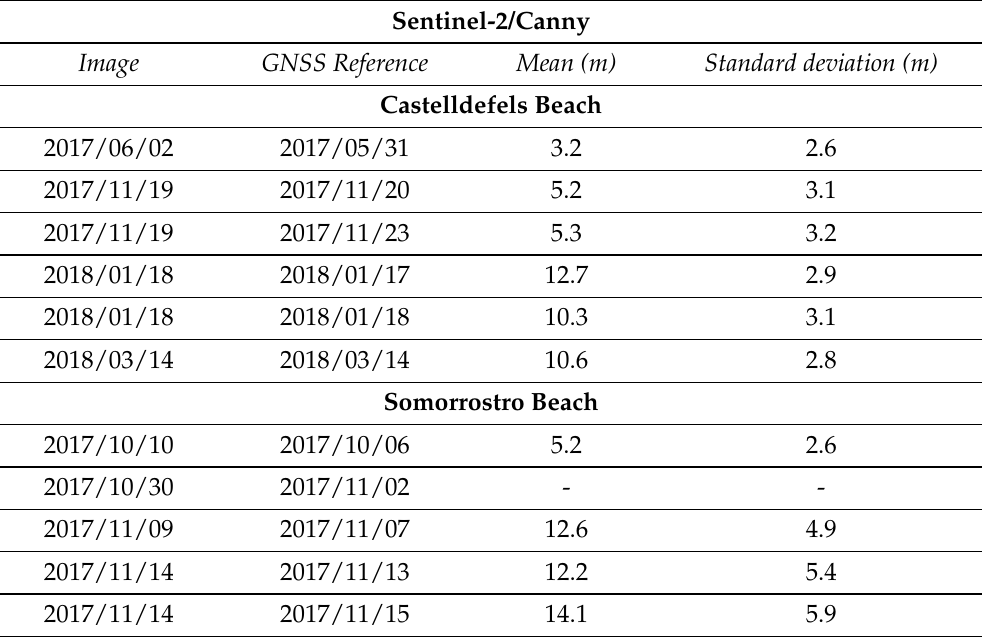
Table 5. Mean and standard deviation of the distances between Sentinel-2 shorelines and GNSS reference points in Castelldefels and in Somorrostro beaches by using the commonly used Canny Edge Detector algorithm.